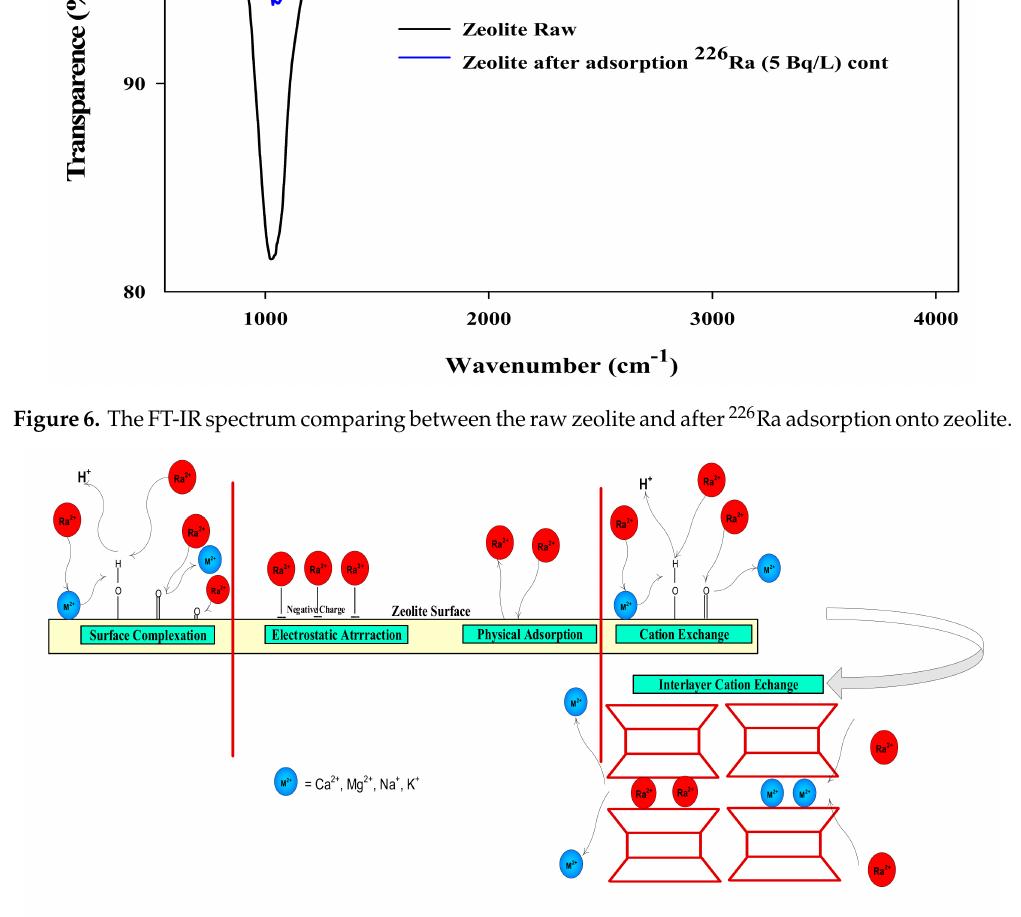
Figure 7. The various proposed mechanisms for the sorption of 226 Ra onto zeolite